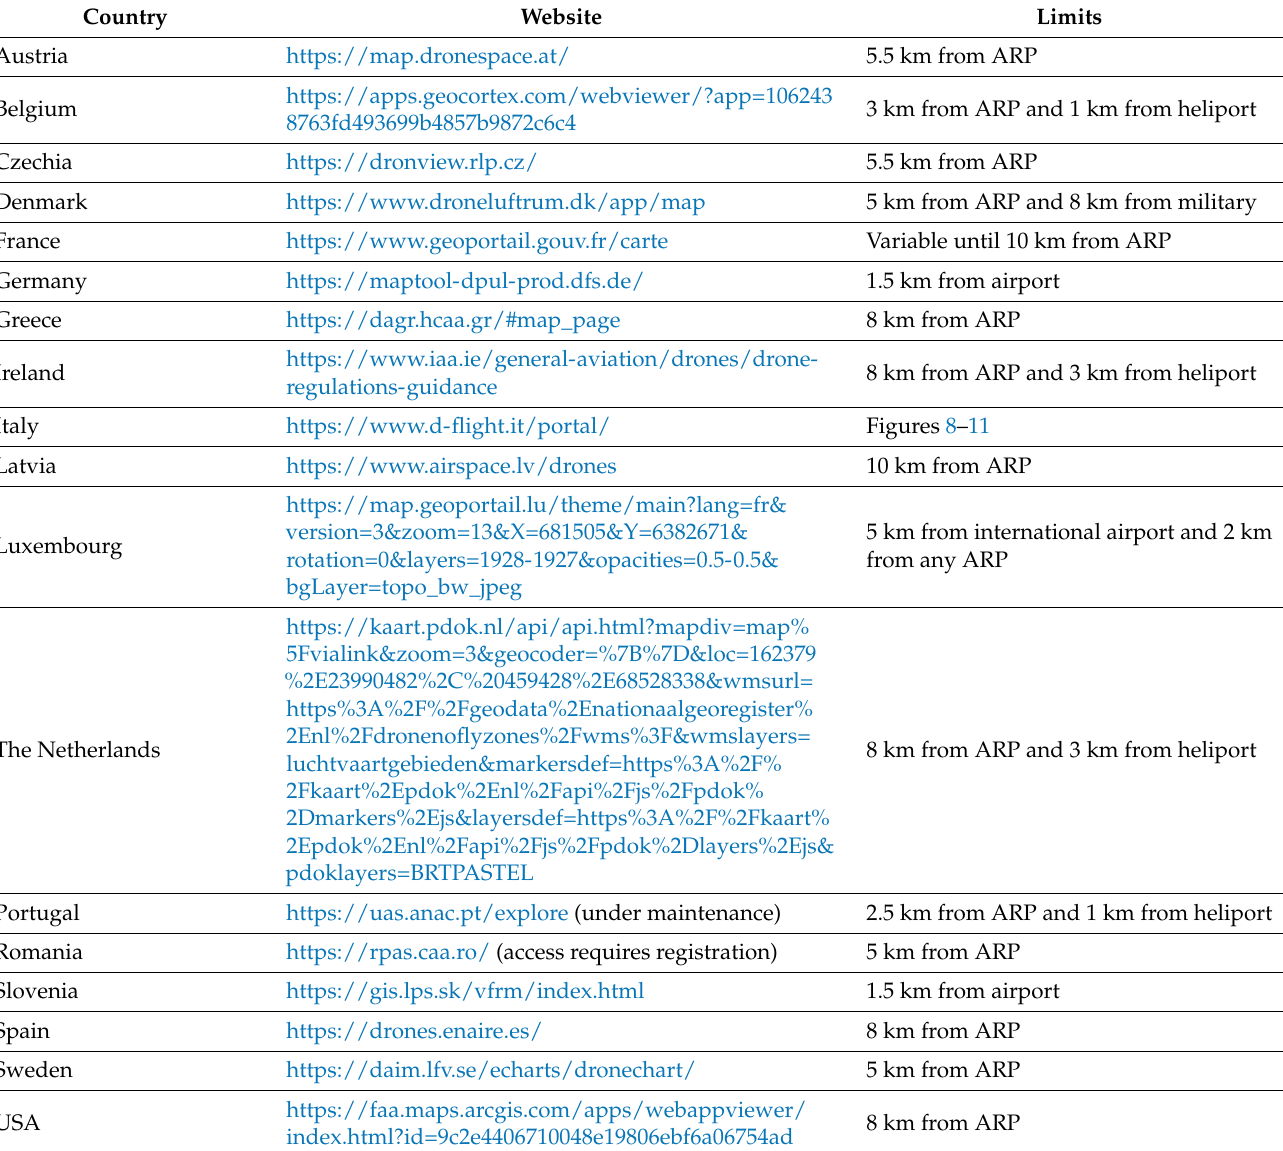
Table 1. Constraints and limitations for geographical areas in most of the EU member states and the USA (accessed on 26 June